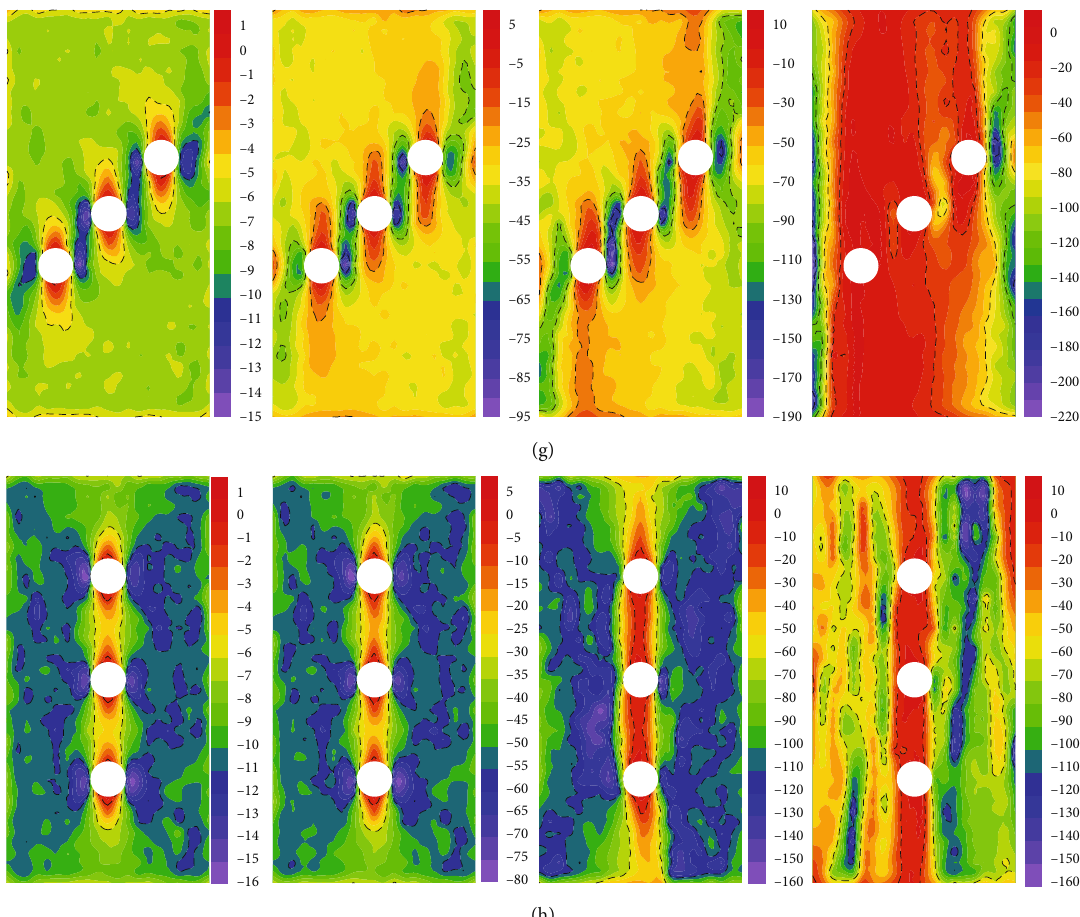
Figure 6: Distinguishing distribution features of the vertical stress fi eld: (a) represents the intact model; (b – h) represent the NM-1 to the NM-7 model,